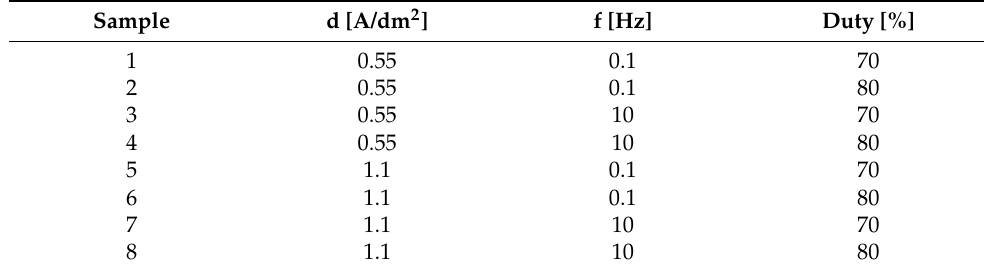
Table 6. Test scenarios and their